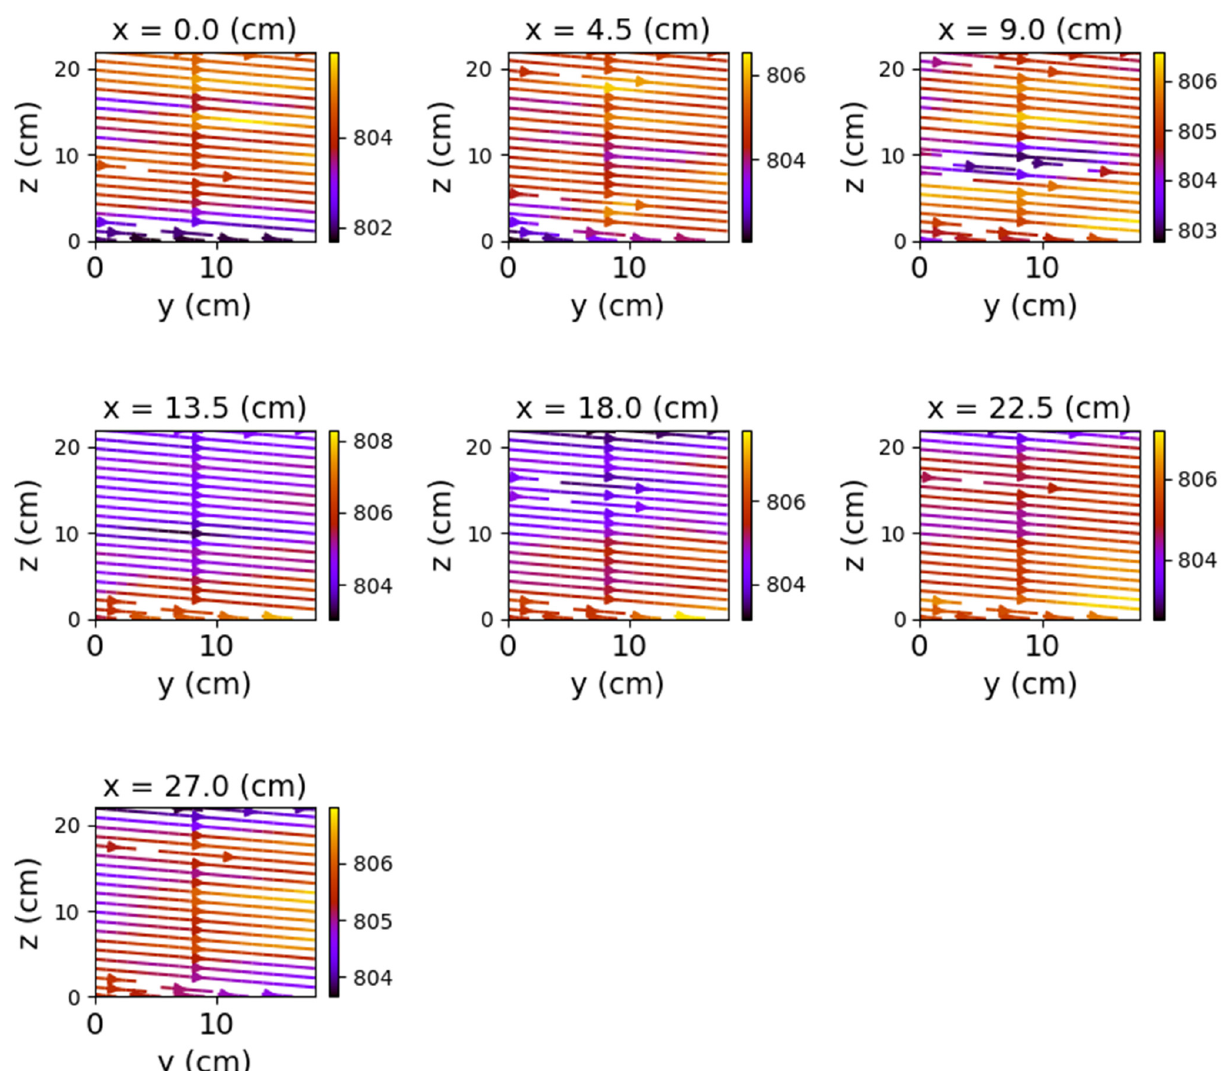
Figure 9. Field lines for y O z plane—non-powered relay.